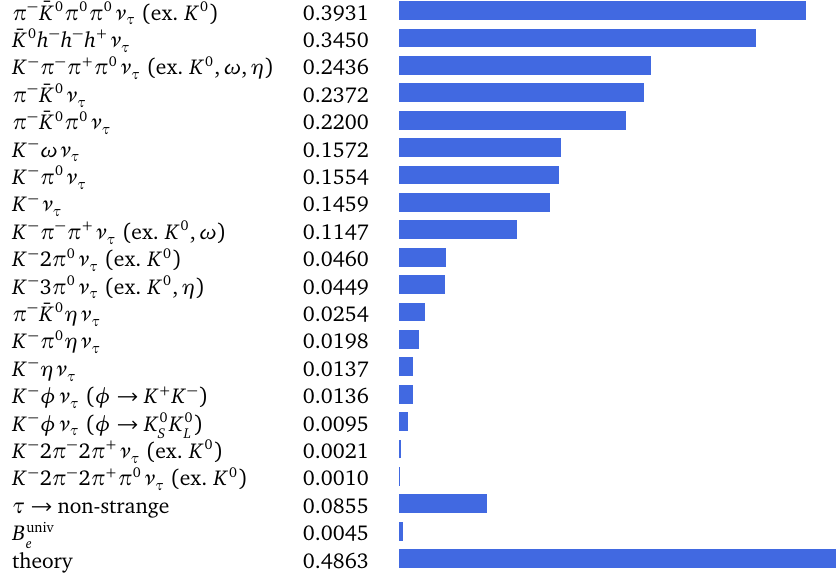
| τ s uncertainty in percent after the B A B AR 2018 re-